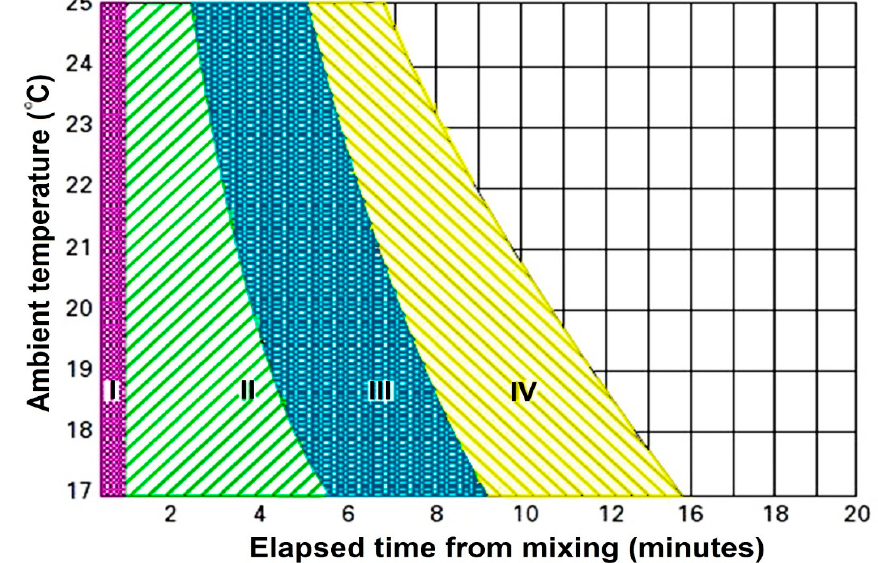
Figure 3. Four polymerization steps for PMMA-based BCs are introduced with four distinct phases that change as a function of the ambient temperature, I: mixing phase; II: waiting phase; III: application phase and IV: setting phase